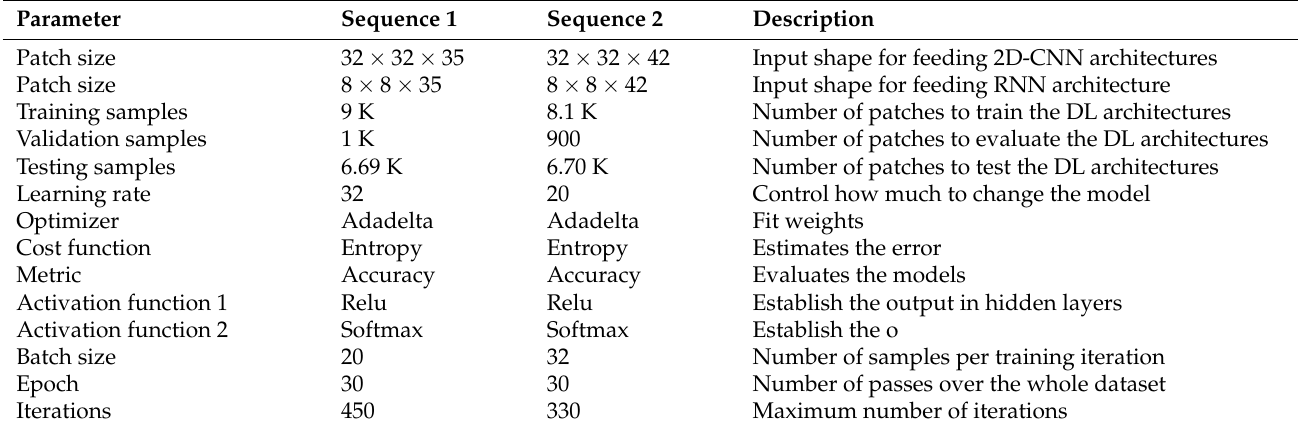
Table 3. Parameter values for all